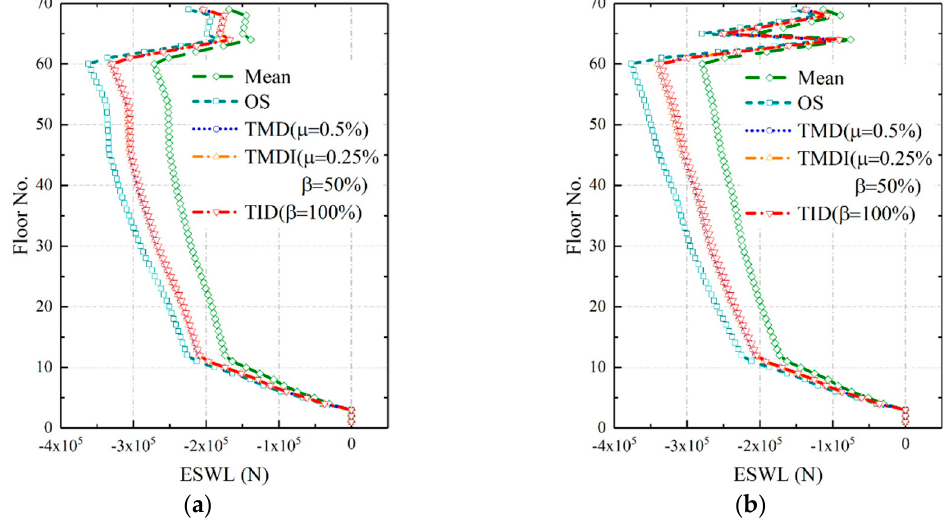
Figure 19. Variation of ESWLs along the building height corresponding to two wind directions: ( a ) 0° wind direction; ( b ) 45° wind direction.